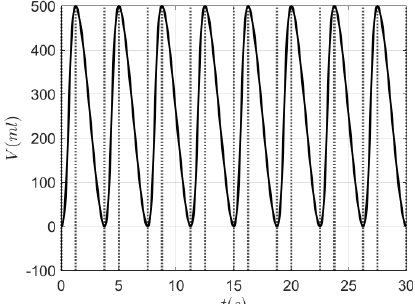
Figure 6. Volume of air insufflated into the patient - case study